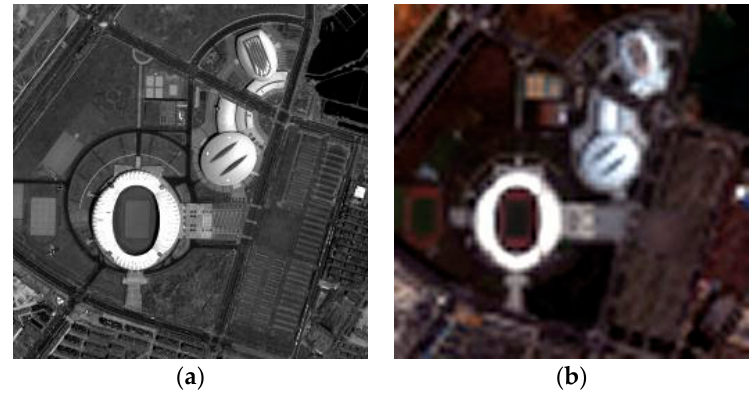
Figure 9. Experimental datasets in the validation of proposed pansharpening method based on three-layer decomposition over the traditional two-layer decomposition. ( a ) IKONOS PAN image; ( b ) IKONOS MS image with bicubic resampling.